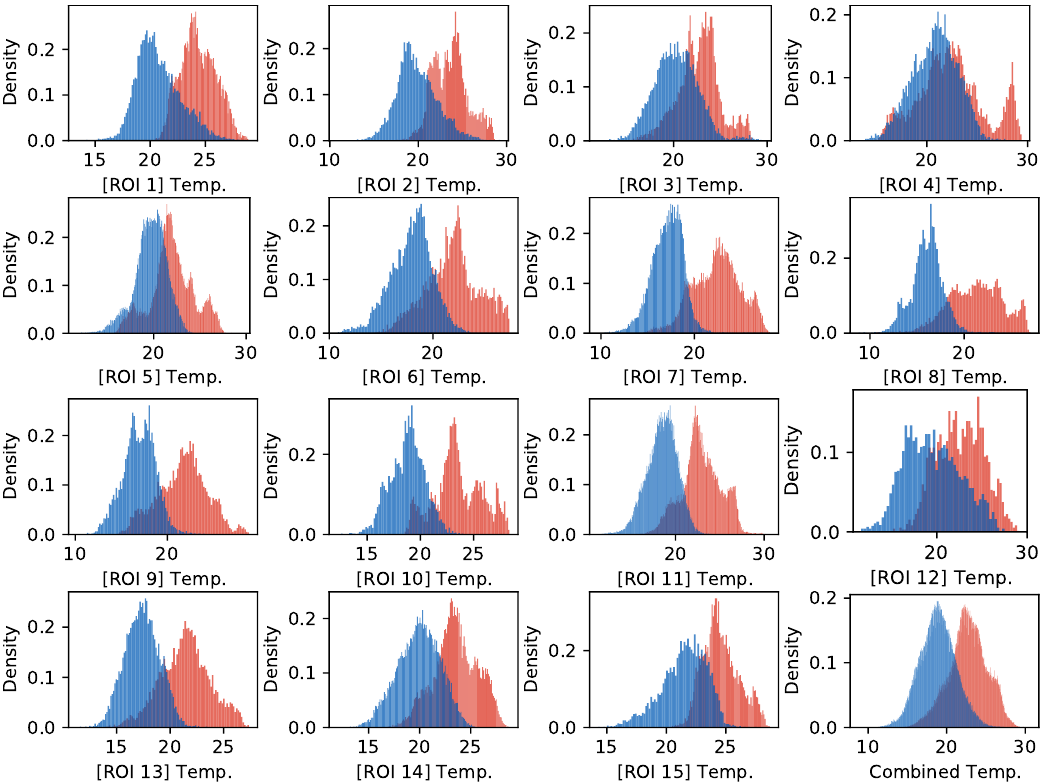
Figure A1. Histograms of temperatures for every ROI. The red color denotes horses, and the blue color denotes donkeys. The last plot presents the combined histogram for all